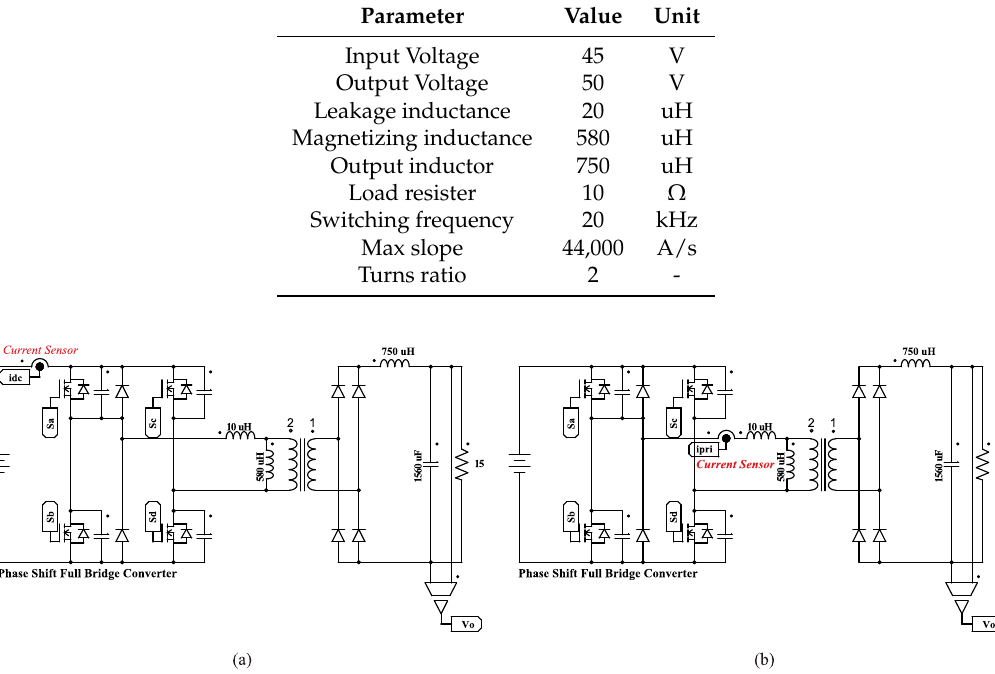
Figure 15. Simulation circuit of PSFB converters using Powersim: ( a ) PCMC circuit; ( b ) HCMC